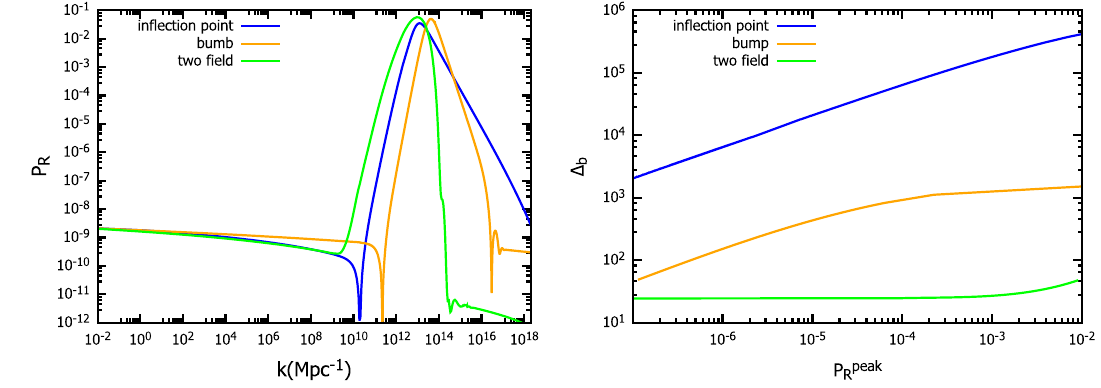
Fig. 8 The level of fine-tuning for our model (blue) with comparison with this amount from other